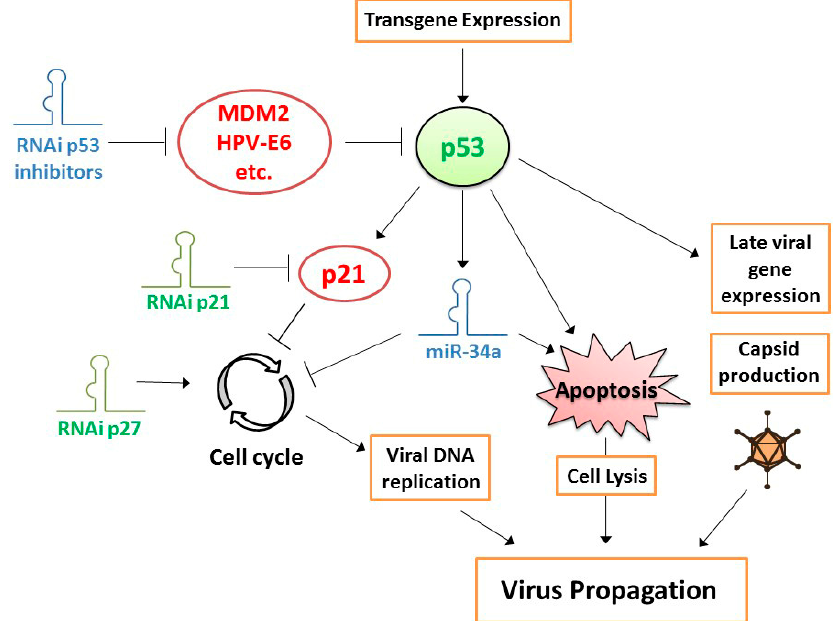
Figure 1. Tumor suppressor p53-dependent strategies to increase the potency of conditionally replicating adenoviruses (CRAds). Expression of functional p53 in cancer cells promotes CRAd propagation by stimulating late viral gene expression and accelerating cell lysis to release virus progeny. In contrast, direct p53 target p21 inhibits the cell cycle and, thereby, viral DNA replication. Silencing cyclin-dependent kinase inhibitors p21 or p27 through RNA interference (RNAi) alleviates cell cycle arrest and, thus, promotes viral DNA replication. Potential other means of promoting CRAd propagation include silencing of p53 inhibitors, which are known to inhibit CRAd replication, and silencing of p53 transcriptional target microRNA (miR)-34a. Molecules in red depict confirmed inhibitors of CRAd efficacy; molecules in green depict confirmed stimulators of CRAd efficacy; molecules in blue depict proposed, but not yet experimentally confirmed modulators of CRAd efficacy; orange delineated viral processes can be influenced to increase potency; cellular processes that are affected by viruses during infection and that can be modulated by transgenes and RNAi molecules expressed by armed CRAds are delineated in black.